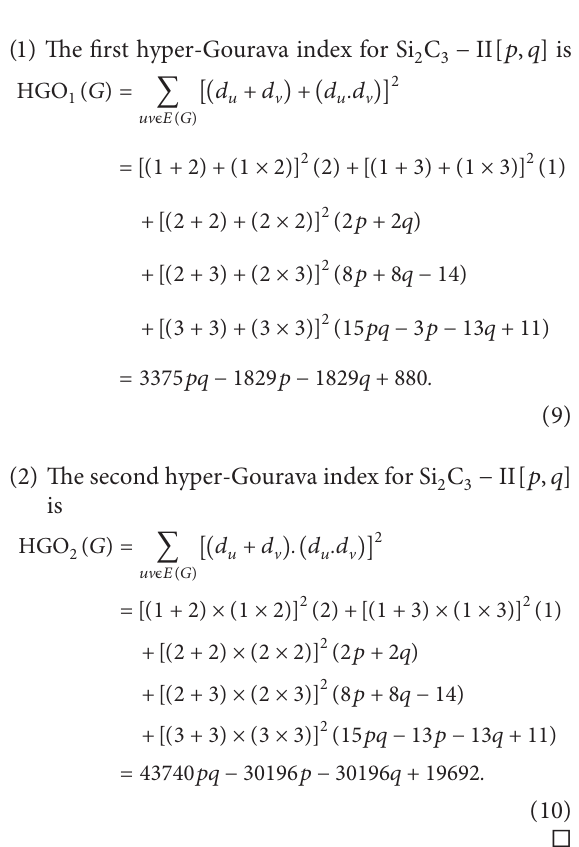
− II [ p, q ] for p � 5, q � C 2 3